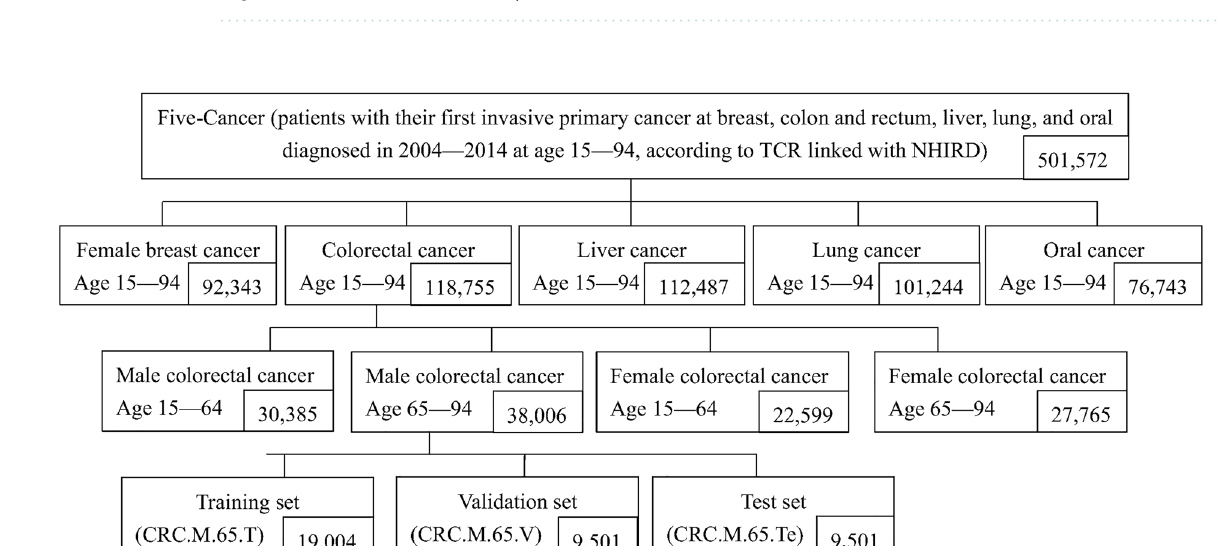
Figure 1. Flow chart of this study.